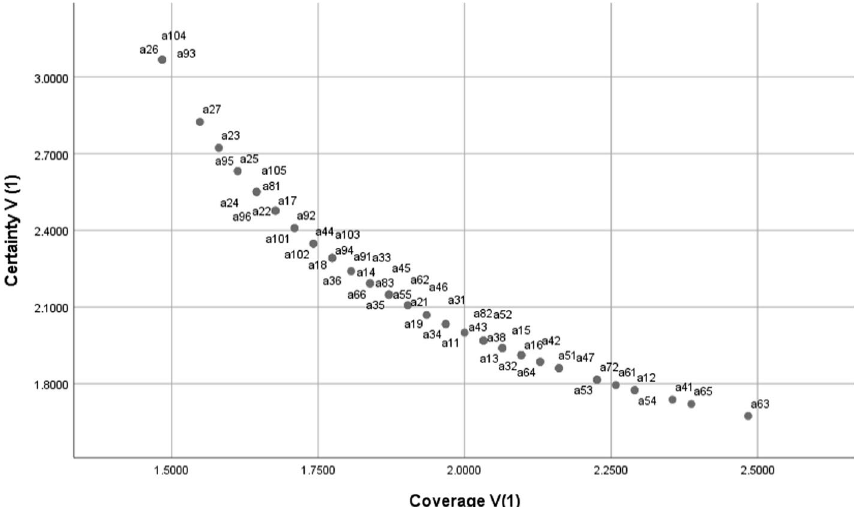
Fig. 8 The scatter plot between the highest interdependency and the highest implication of risk